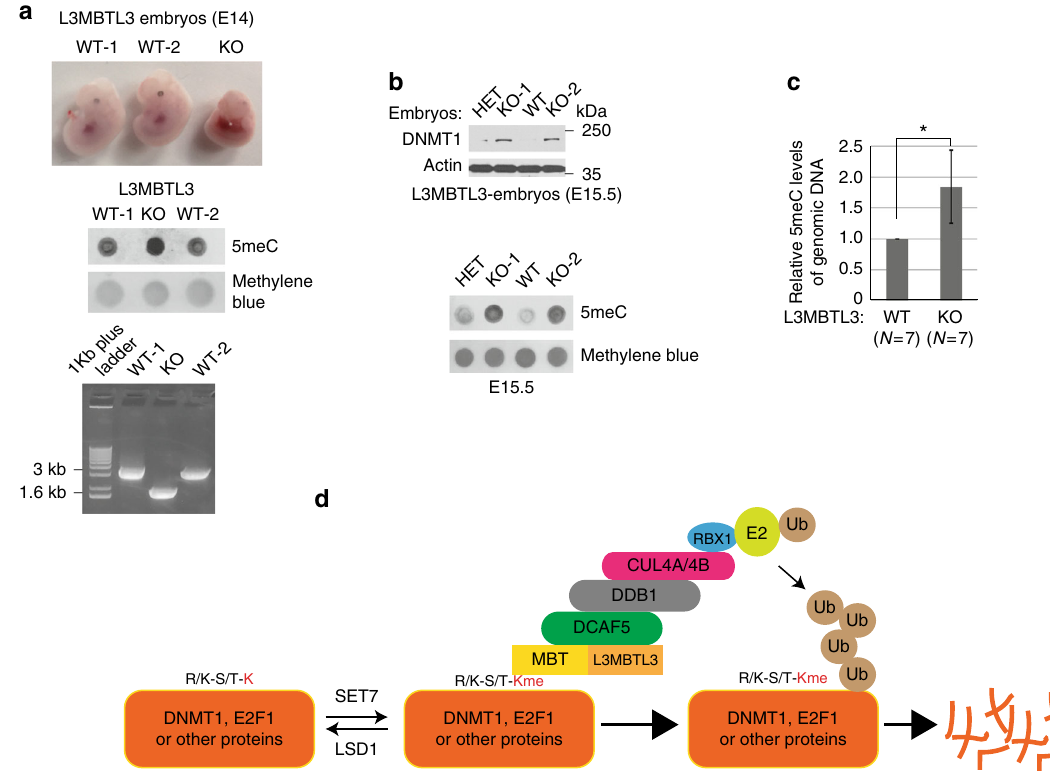
Fig. 10 Effects of L3MBTL3 null mutation in mouse embryos and a model for the degradation of methylated proteins. a Deletion of mouse L3MBTL3 gene is embryonic lethal. The mouse wild-type (WT) and L3MBTL3 null ( − / − , KO) mutant embryos at embryonic day 14 (E14) after breeding. The genomic DNA from two wild-type and the KO embryos were extracted and used for genome-typing and 40 ng of the genomic DNA from each embryo was heat denatured, spotted onto the Genescreen membrane, and blotted with the anti-5-methylcytosine antibody (5mC) using the Methylene Blue staining as the loading control. b The levels of DNMT1 protein and methylated DNA increased in L3MBTL3 KO mutants. The mouse wild-type (WT), heterozygous (HET), and L3MBTL3 null (KO) mutant embryos at E15.5 from the same female mouse were used to analyze the levels of DNMT1 protein and methylated genomic DNA as indicated, with anti-DNMT1 and anti-5mC antibodies. c The relative methylated DNA content in L3MBTL3 wild-type ( + / + , N = 7) and KO ( − / − , N = 7) mutant embryos from 6 different female mice between E14 and E15.5 was examined and compared. Statistically signi fi cant differences between means of methylated DNA levels in wild-type and knockout mutants were compared using two-tailed equal-variance independent Student ’ s t -test. * P < 0.05. The levels of methylated DNA in the wild-type embryos were normalized and set as 1.0. Quanti fi cations were represented by bar graph with mean and standard deviation (S.D.) for error bars from 7 L3MBTL3 KO embryos ( N = 7) containing the elevated methylated DNA, which also correlated with the increased levels of DNMT1 protein in these KO embryos (please see Supplementary Figure 5 for more examples). d A schematic model for the ubiquitin- dependent proteolysis of the methylated R/K-S/T-K motif-containing proteins by L3MBTL3 and CRL4 DCAF5 ubiquitin E3 ligase complexes. The lysine residue (red and bold K) within the consensus R/K-S/T-K motif is dynamically methylated or demethylated by SET7 or LSD1, respectively. The monomethylated lysine residue (red and bold Kme) is recognized by the MBT domain of L3MBTL3. L3MBTL3 further interacts with the CRL4 DCAF5 ubiquitin E3 ligase complex to target the methylated protein substrates for polyubiquitination-dependent